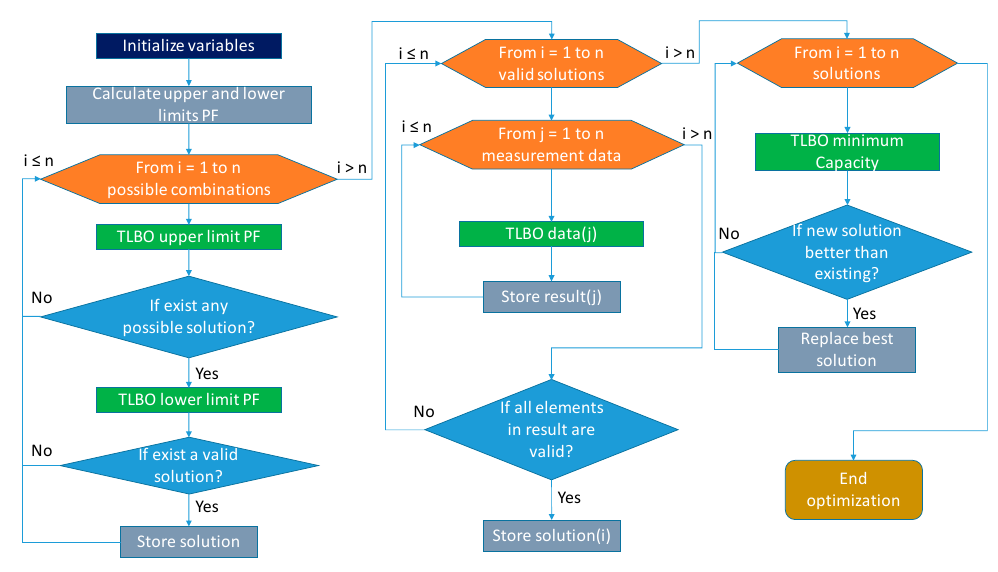
Figure 2. Flow chart of the capacitor bank optimization (CBO) Algorithm.